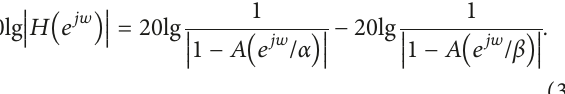
A z / c 1 frequency response for different c values. ( − ( ))